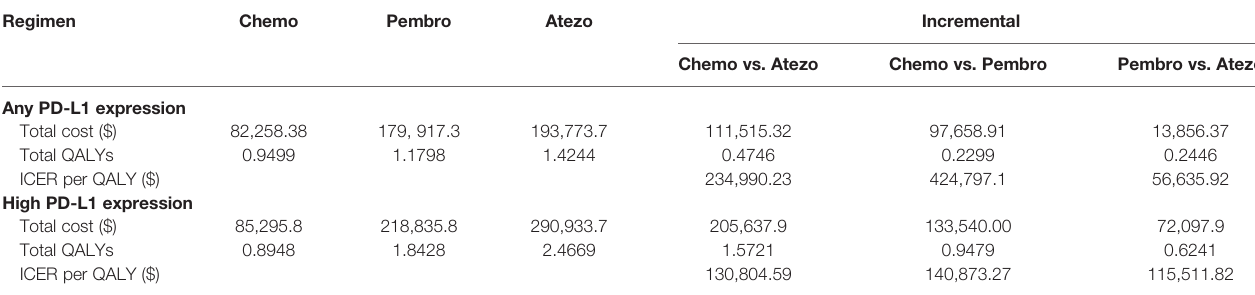
TABLE 2 | Summary of cost and effectiveness results.